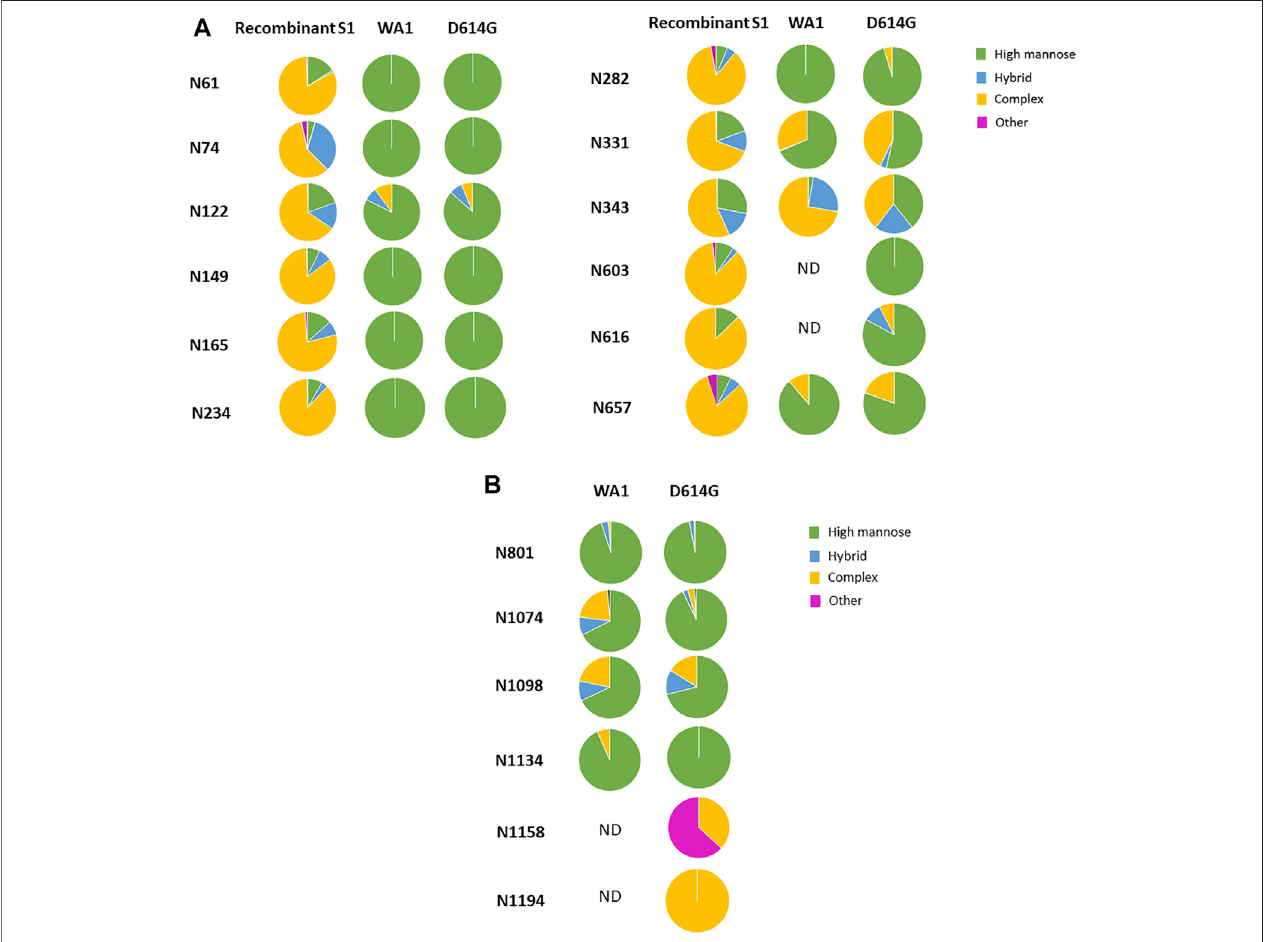
FIGURE 6 | Comparison of the glycosylation pattern on the spike protein from recombinant S1, the WA1 strain, and the D614G variant. The most abundant glycoformsdetectedinVeroE6cell-derivedWA1and D614GstrainspikeN-glycositeswerecomparablebut differentfromthatdetected inrecombinantS1produced in HEK293. (A) N-linked glycan subtypes in the S1 domain. (B) N-linked glycan subtypes in the S2 domain.